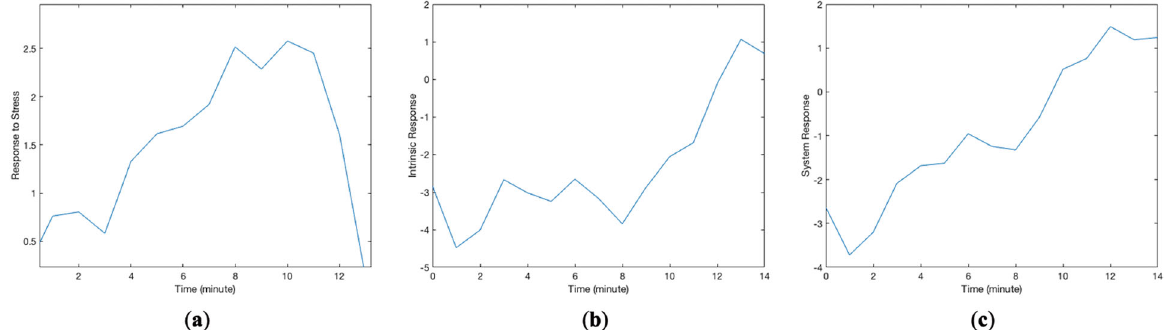
Fig. 3 Different responses of the identi fi ed system for one data chunk. a Response of the system to predictor (stress), y cause , b intrinsic response of the system, y intrinsic , and c system response, which is the sum of response to predictor and intrinsic response, y system